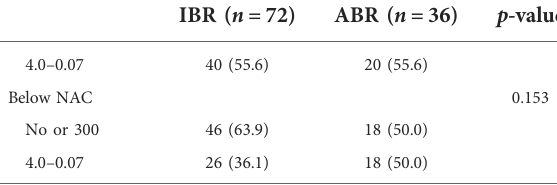
TABLE 2 Surgical outcome parameters of all patients who underwent primary breast